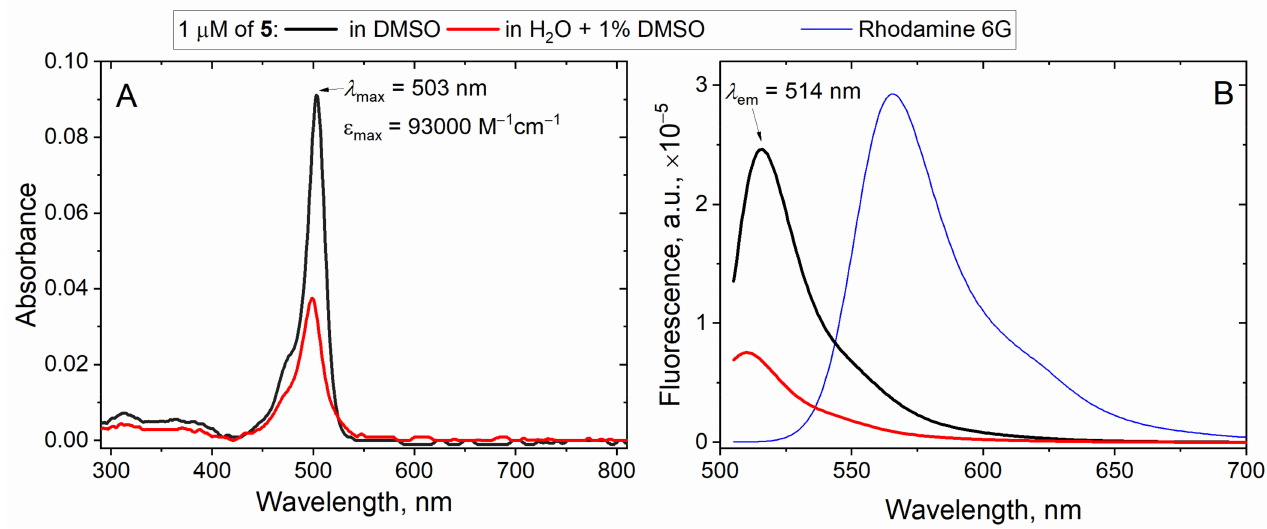
Figure 2. ( A ) UV–Vis absorption spectrum of 5 . ( B ) Emission spectrum of 5 (excitation: 500 nm). Fluorescence spectrum of Rhodamine 6G (DMSO solution with matched absorption at 500 nm) is shown for the